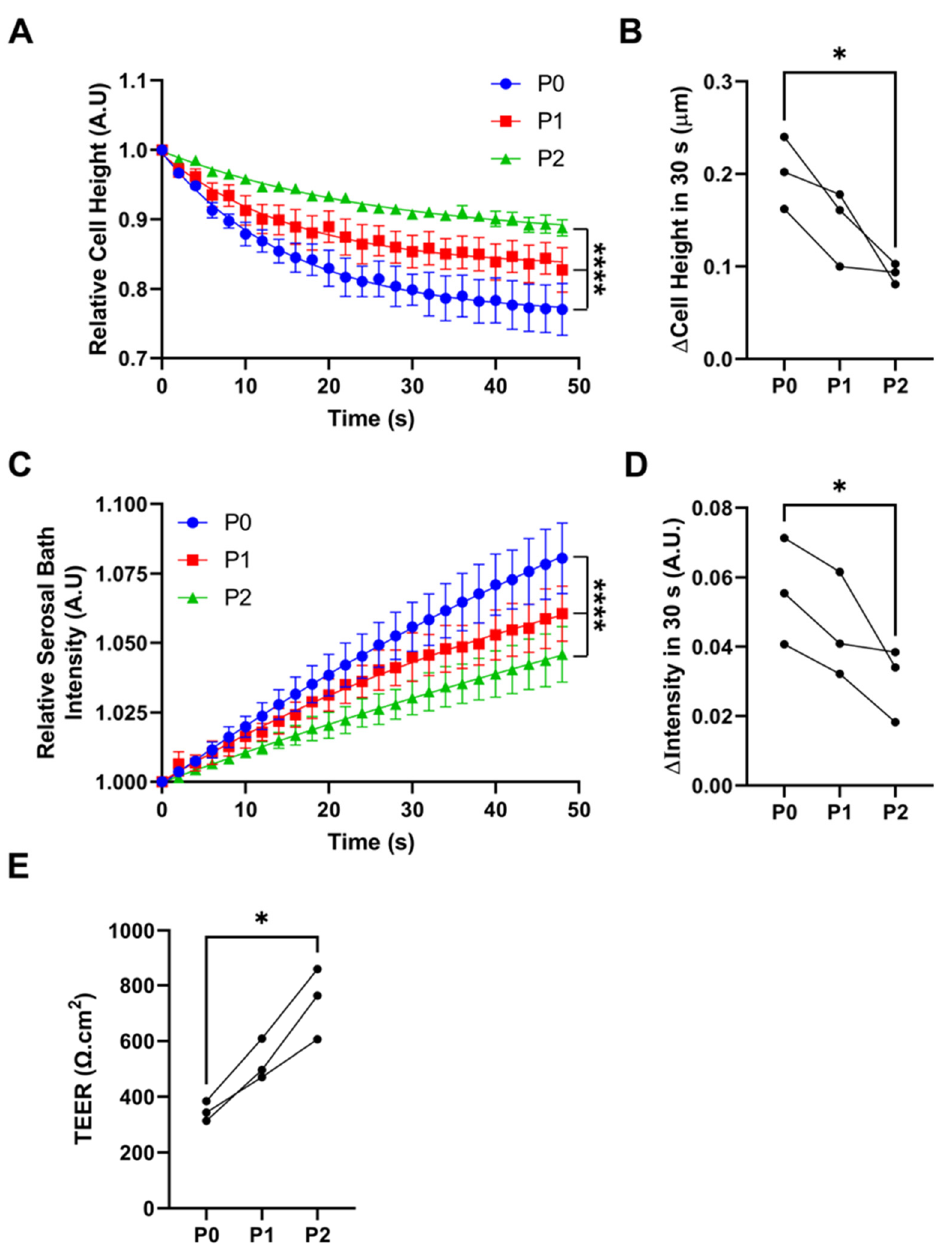
Figure 3. Passaging HBECs alters cell volume regulation. ( A ) Cell height in response to mucosal addition of 200 mL of hyperosmotic solution. ( B ) Summary cell height data. ( C ) Serosal bath intensity over time after the serosal addition of a bolus of rodamine–dextran-labeled saline. ( D ) Summary serosal bath intensity data. ( E ) Transepithelial resistance (T.E.R.) of differentiated HBEC ALI cultures at different passage numbers. n = 3, * = p < 0.05, Friedman test. **** p < 0.001 extra-sum-of-squares F test.